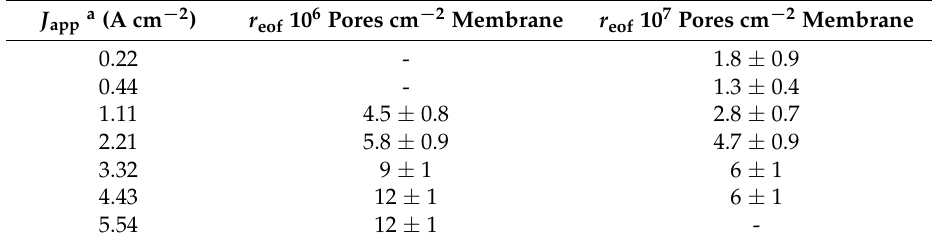
Table 4. EOF rectification ratios for membranes with 10 6 and 10 7 pores cm − 2 at different applied current densities J app . Reproduced with permission [32]. Copyright 2015, American Chemical Society.